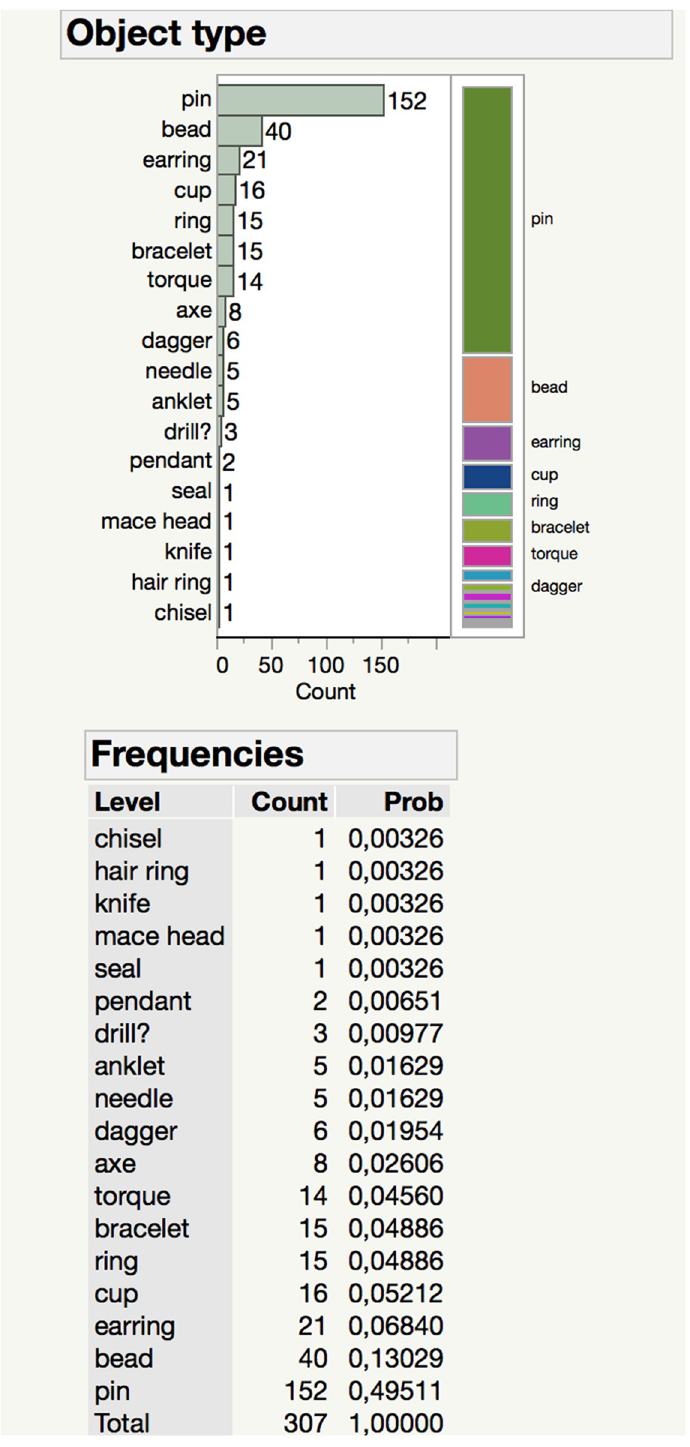
Fig 6. Distribution of artifacts according to